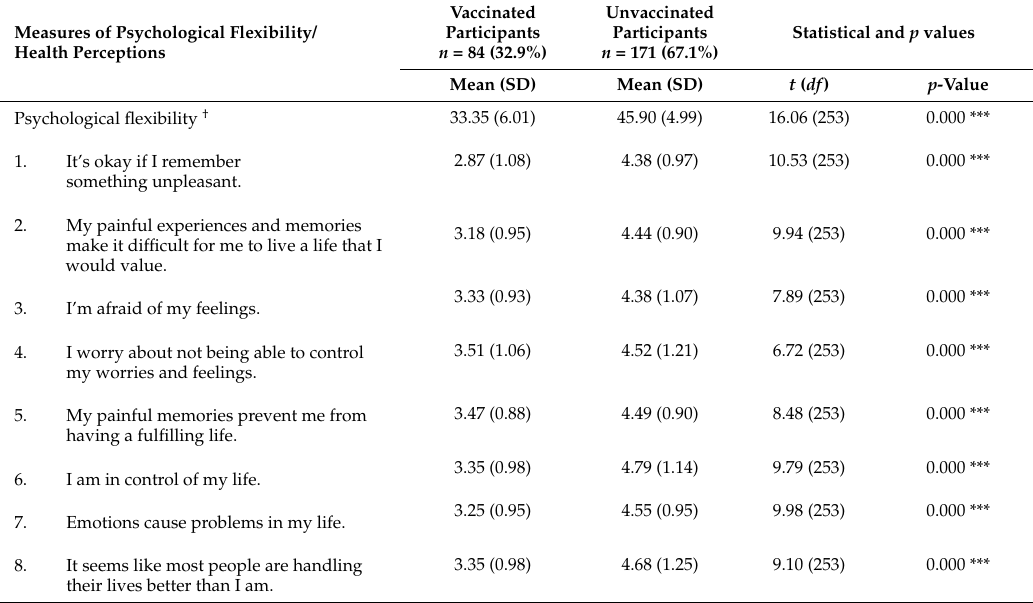
Table 2. Comparison of psychological flexibility and health perceptions between the vaccinated and unvaccinated